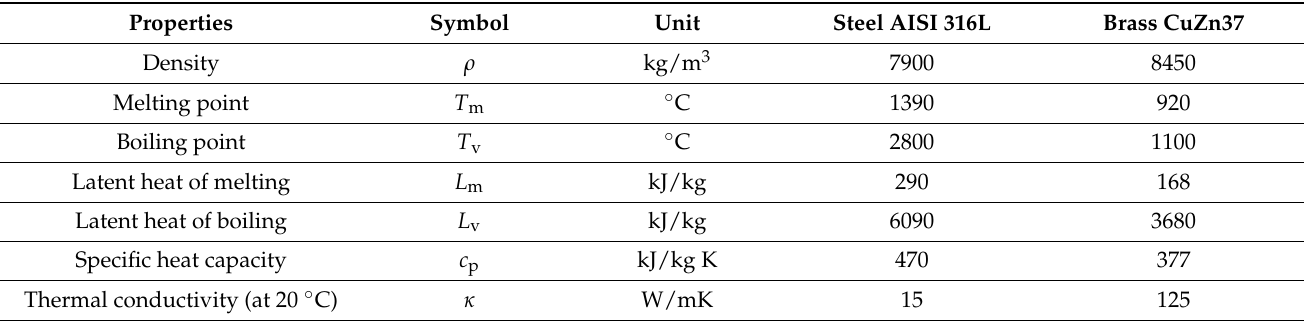
Table 1. Physical properties of steel AISI 316L and brass CuZn37